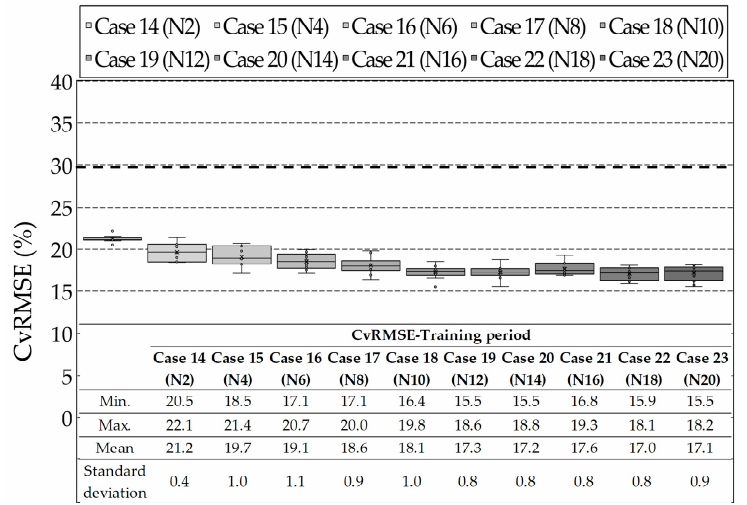
Figure 7. Accuracy according to the number of neurons used in the training period.